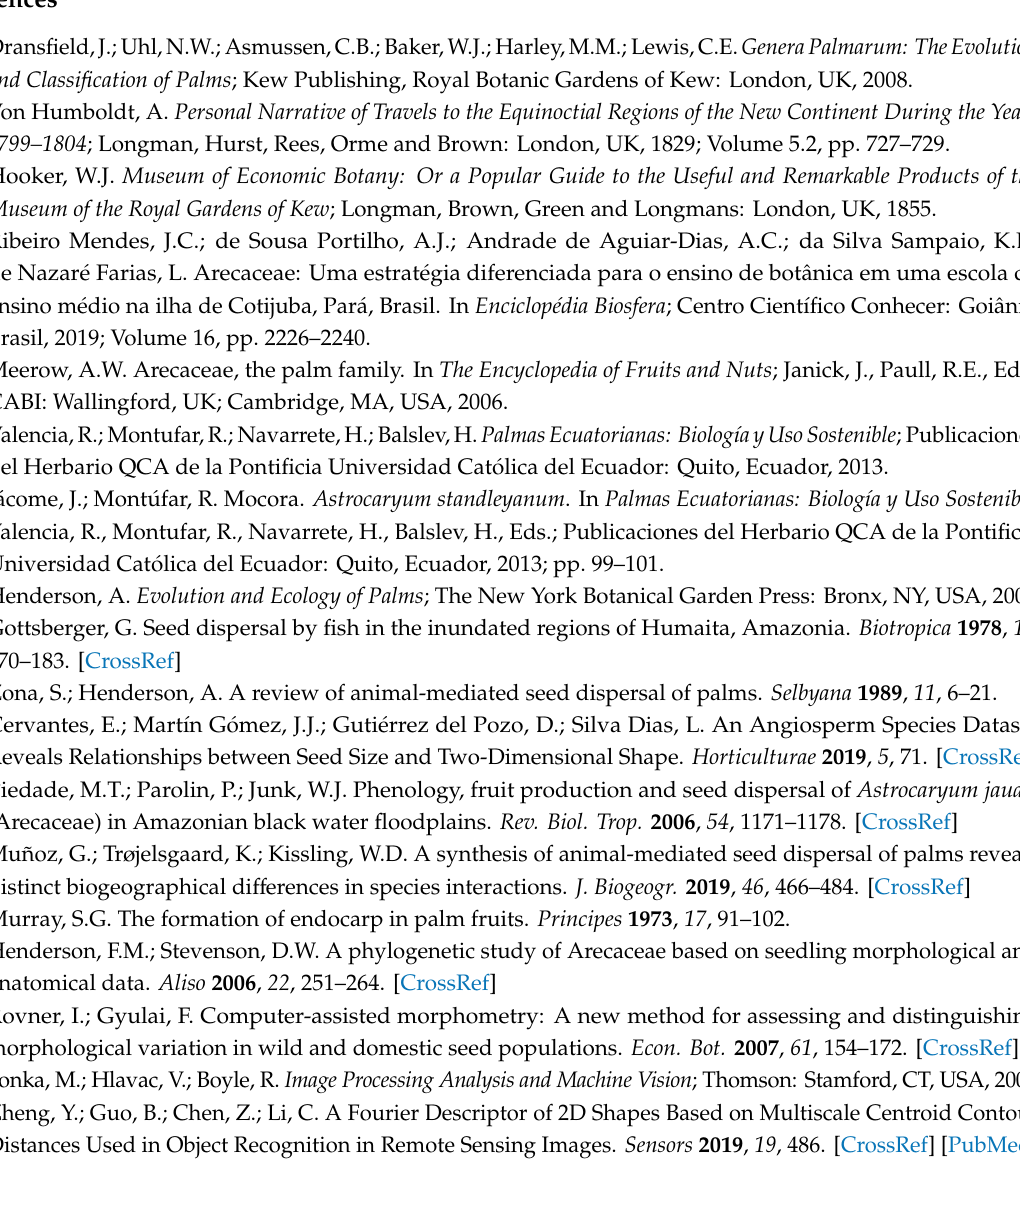
Figure 10: Seeds were collected at Pastaza (Ecuador) in di ff erent urban gardens of Puyo and, after being photographed, the seeds were returned to their origin. Figure 11: Seed collection